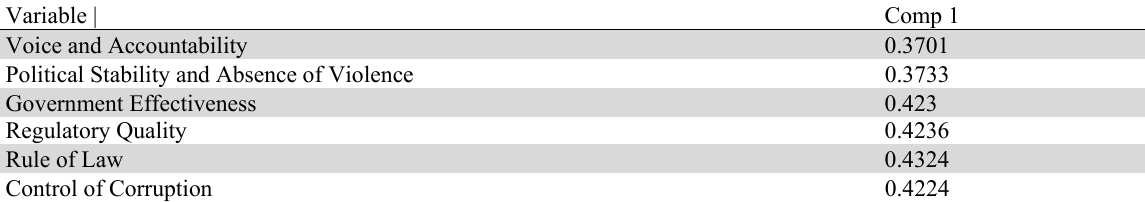
Factor pattern on the first component Variable